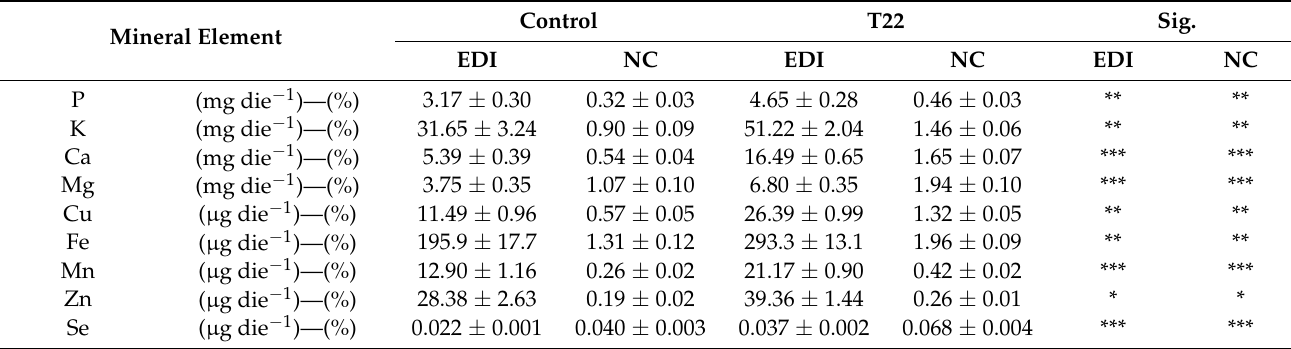
Table 2. Estimated Daily Intake (EDI) and Nutrient Contribution (NC) of Pixel tomato fruits under control or T. harzianum strain t22 biostimulant treatments.